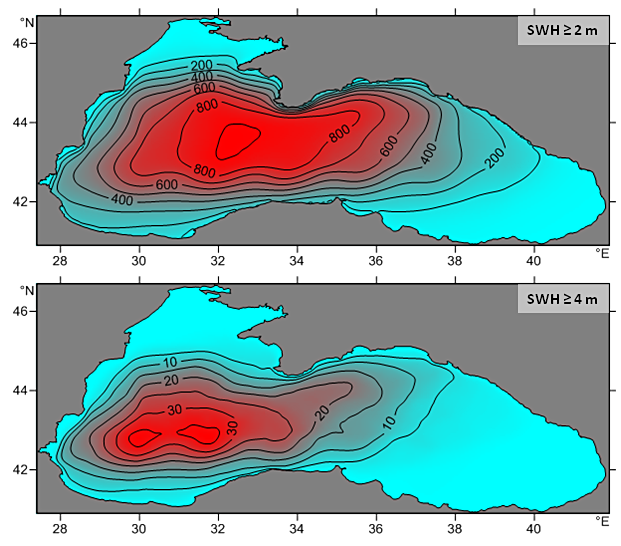
Figure 21. Total duration [days] of waves with SWH exceeding 2 and 4m over the entire hindcast period.